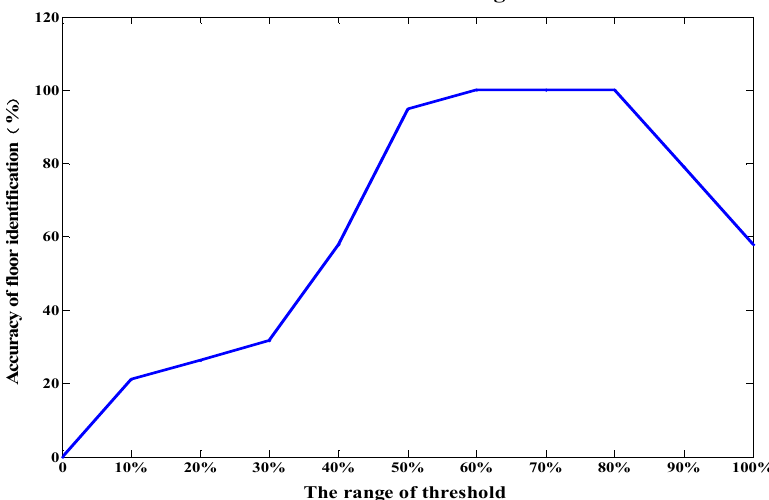
Figure 12. Impact of the threshold of MAC repetition rate on floor identification’s accuracy.